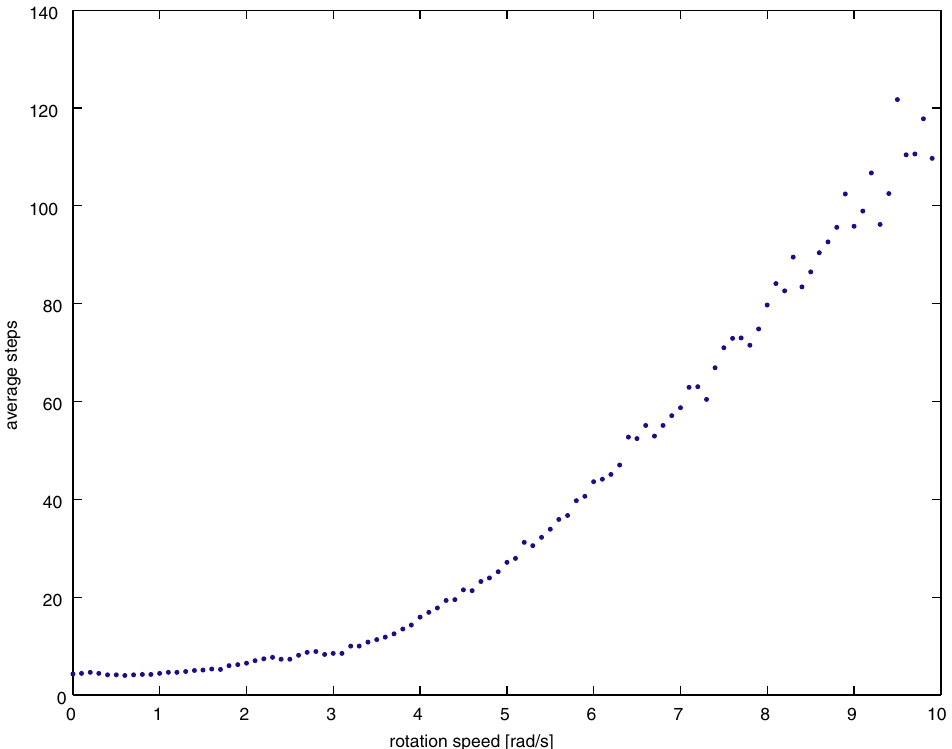
Figure 3 Stabilisation of the kneeless walker under constant noise 3D simulation. The simulation under noise shows that the number of walked steps depends on the rotation speed of the gyro. The graph shows the average number of steps (100 trials) as a function of the speed of the